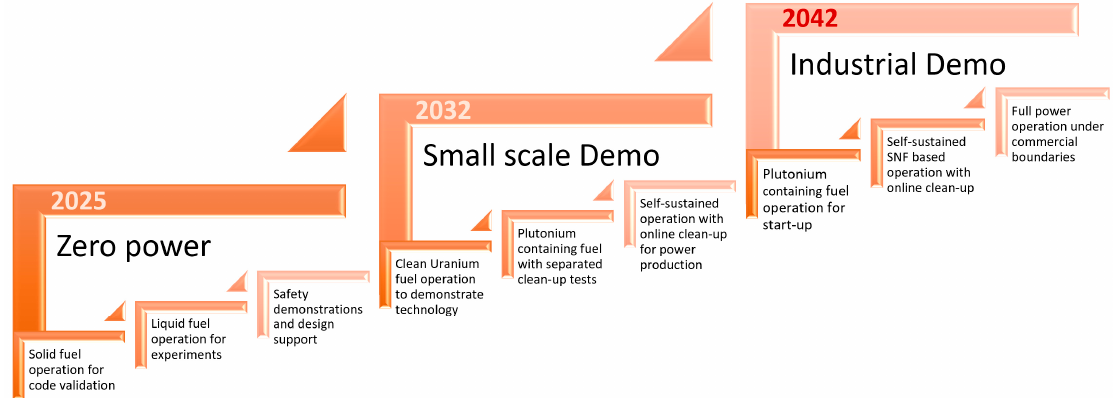
Figure 12. Proposed approach for a step-by-step approach for the development of iMAGINE with indicative dates.